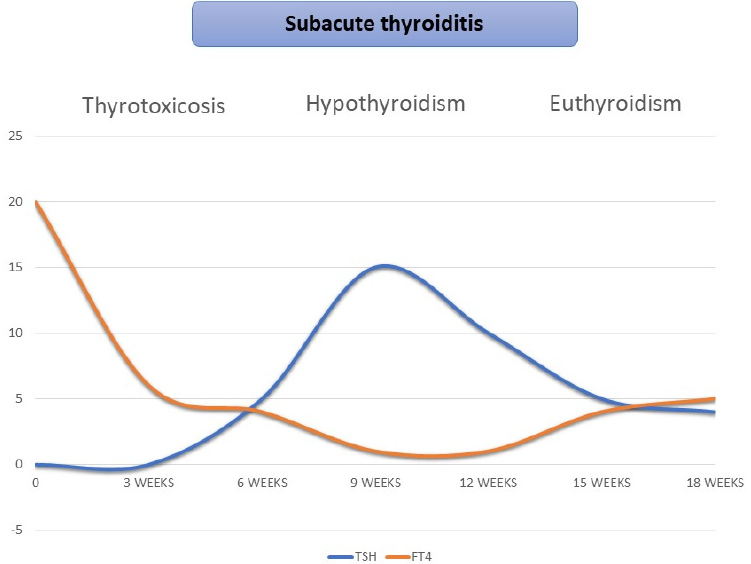
Figure 1. Classic triphasic pattern of subacute thyroiditis.